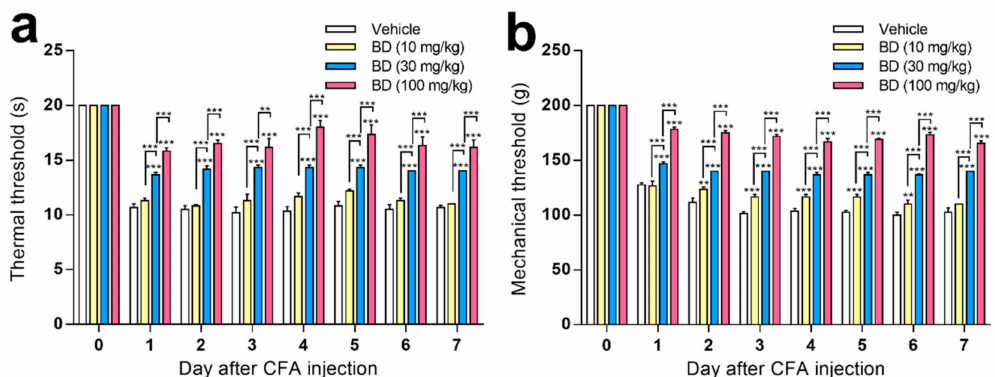
Figure 3. The effect of BD1047 (BD) on complete Freund’s adjuvant (CFA)-induced hyperalgesia. Repeated administration of BD1047 (7 days, daily) dose-dependently inhibited the development of CFA-induced thermal hyperalgesia ( a ) and mechanical hyperalgesia ( b ). ** p < 0.01, *** p < 0.001 (compared with Vehicle group of each time-point; n = six rats in each group; data represent the mean ± SEM; Bonferroni’s multiple comparison test; dose-response analysis using Tukey’s multiple comparison